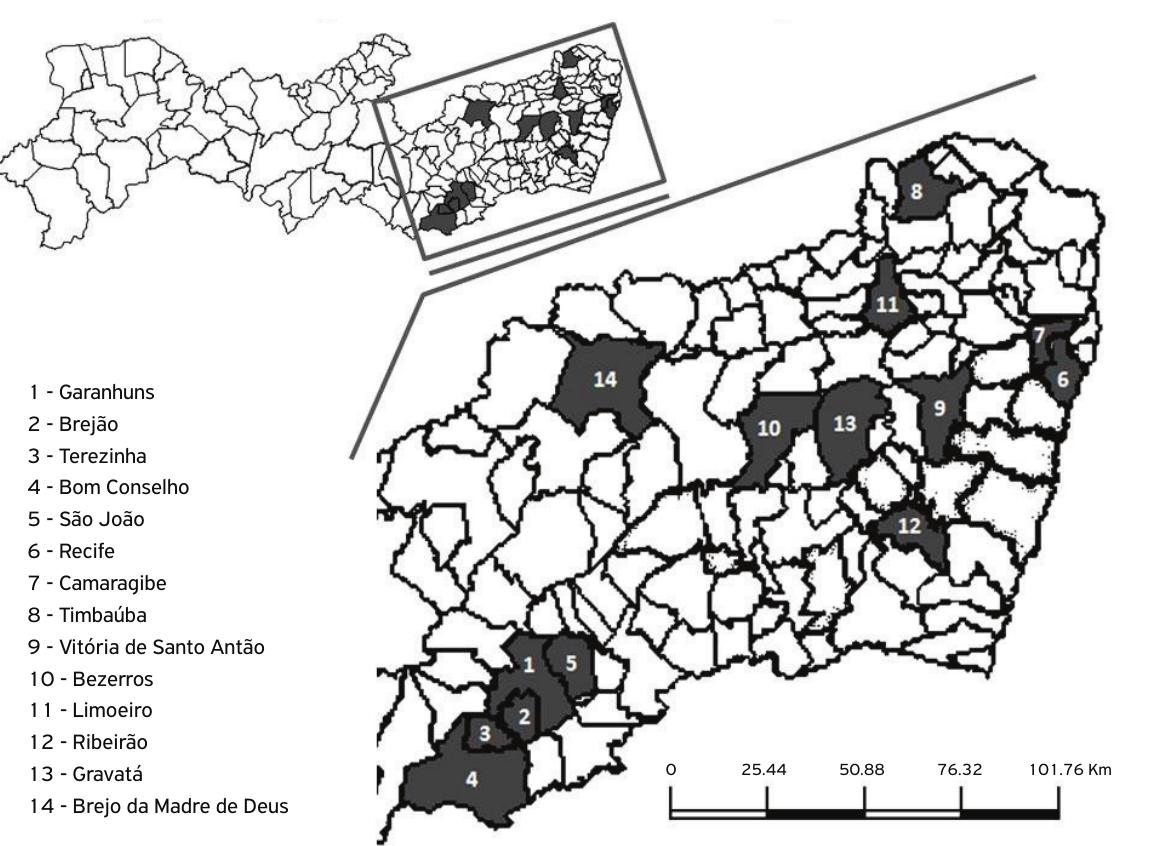
Figure 1. Municipalities studied in the state of